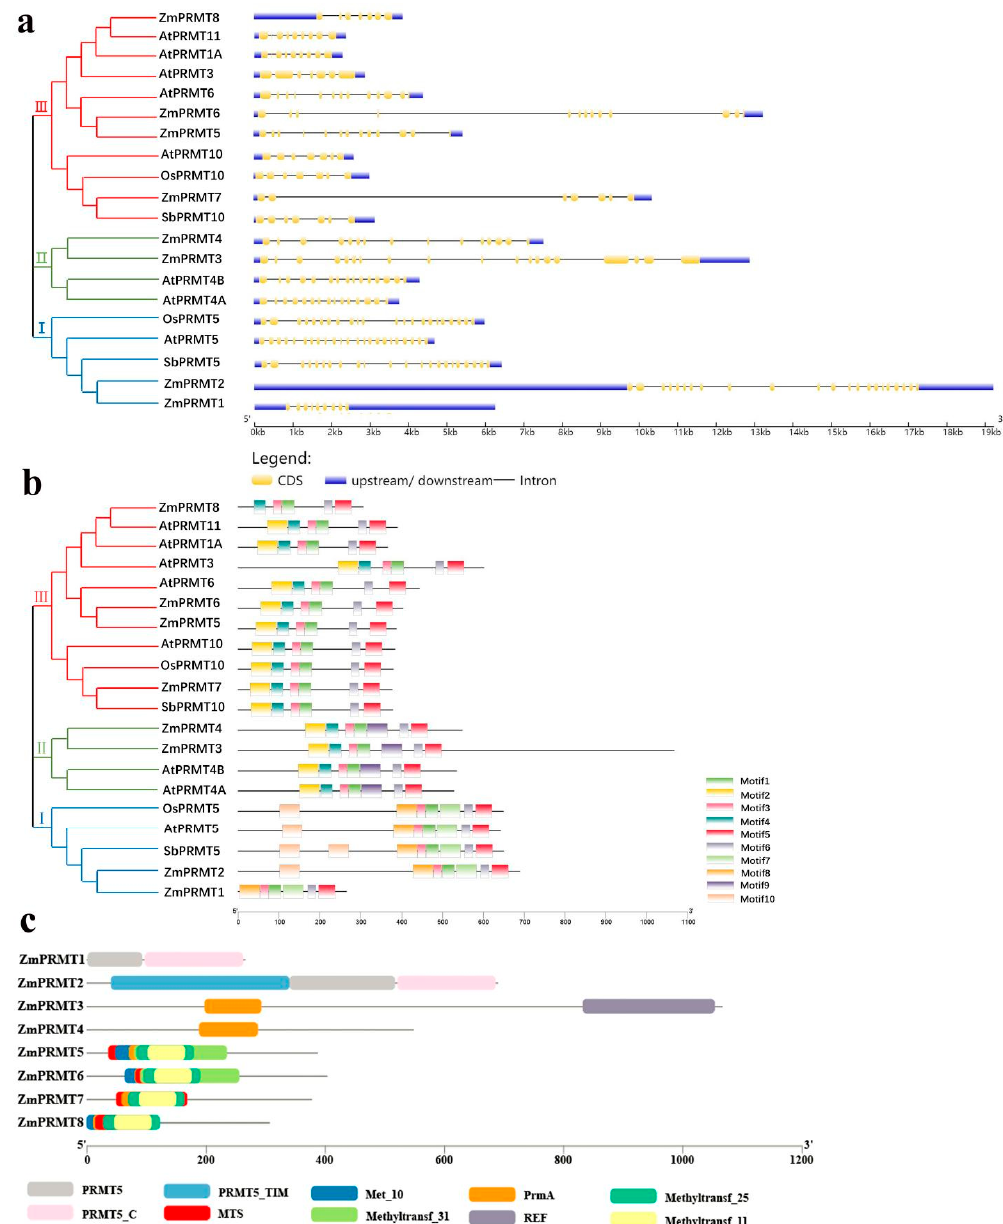
Figure 1. Phylogenetic relationship, gene structure, conserved motif and conserved domain analysis of maize PRMT family from maize, rice, sorghum and Arabidopsis . ( a ) Phylogenetic tree and the corresponding exon–intron structures of PRMT proteins. The maximum-likelihood phylogenetic tree was constructed using MEGA 7.0 with 1000 replicates. Three main clades are marked: I, II and III with different colored ranges. In the exon–intron structures, black lines represent introns, yellow boxes represent exons and the blue boxes represent upstream/downstream regions of PRMT genes. Protein sequences were downloaded from the Maize genome database and NCBI database. ( b ) Phylogenetic tree and the corresponding conserved motifs of PRMT proteins. Ten different colored boxes with numbers are used to represent different conserved motifs. The motifs identified in each group of PRMT proteins were schematically represented using the MEME motif search tool. ( c ) Phylogenetic tree and the corresponding conserved domains of maize PRMT proteins. The 8 PRMT domain sequences of maize were downloaded from the Smart database. Protein is represented by gray line. The position to the left of the gray line represents the N-terminal of each protein. Different colored rectangles are used to represent the domains contained in